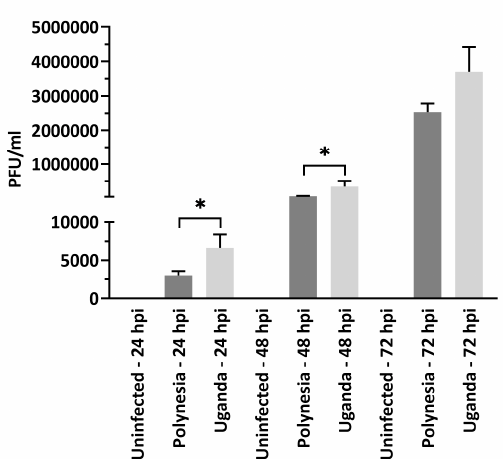
Figure 2. Plaque forming assays. Quantification was performed in Vero cells by plaque forming assays and the number of infectious viral particles is expressed in plaque forming units per mL (PFU/mL). Error bar represents the mean ± SEM of n = 3 biological replicates; * p < 0.05. Quantification of the number of extracellular infectious viral particles from lt-NES ® cells infected with either the Polynesia or the Uganda strain at 24, 48 and 72 hpi at multiplicity of infection (MOI) of 0.1.